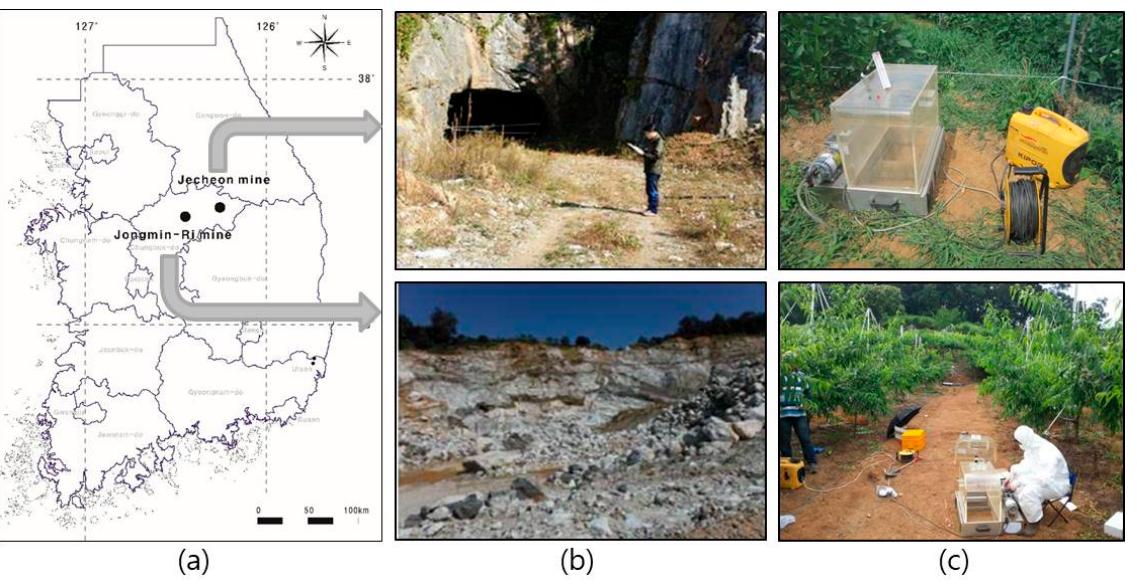
Figure 1. Locations ( a ), mining sites ( b ), and experiment of the modified releasable asbestos sampler (RAS) in the field ( c ).